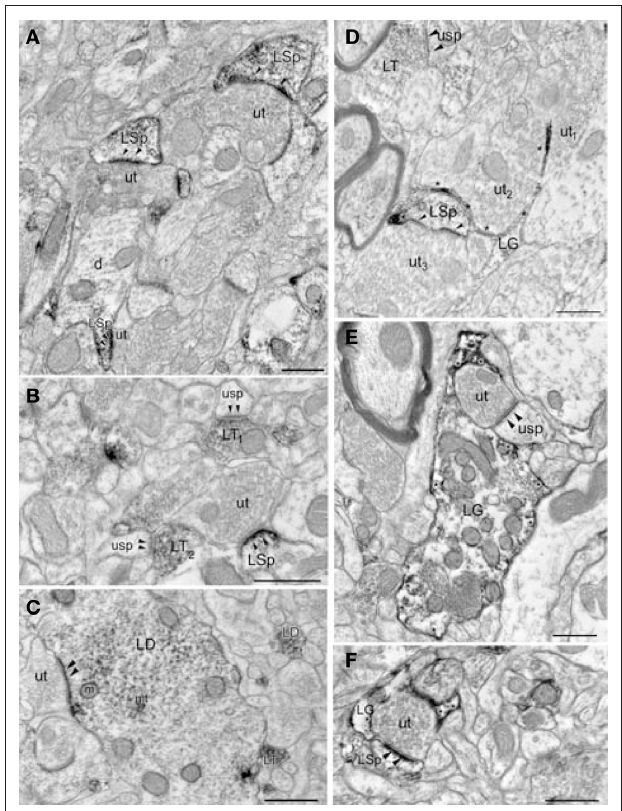
Figure 6 | Both LA neurons and glia are immunoreactive (ir) for β Ar. (A) Unlabeled terminals (ut) form asymmetric synapses onto β AR 248-ir spines (LSp). The spinous portion (LSp) of a dendrite (d) is β AR 248-ir. (B) An unlabeled terminal (ut) synapses (arrowheads) onto a β AR 248-ir spine (LSp). ) synapse (arrowheads) onto unlabeled spines β AR 248-labeled terminals (LT 1–2 (usp). (C) The β AR 248 reaction product in a dendrite (LD) is concentrated at the synapse (arrowheads) formed by an unlabeled terminal (ut) but also rims the microtubules (mt) and mitochondria (m). Also shown are a β AR 248-ir terminal (LT) and a small labeled dendrite (LD). (D) β AR 404-ir glial processes (LG, asterisks) are interposed between two unlabeled terminals (ut ). Also 1–2 shown are an unlabeled terminal (ut ) synapsing (arrowheads) onto a β AR 404 3 ir spine (LSp) and a β AR 404-ir terminal (LT) synapsing (arrowheads) onto an unlabeled spine (usp). (e) A β AR 404-ir glial process (LG) surrounds a terminal (ut) that synapses (arrowheads) onto a spine (usp). Asterisks denote β AR 404-ir along the plasma membrane. (F) A β AR 404 ir glial process (LG, asterisks) surrounds an unlabeled terminal (ut) that forms an asymmetric synapse (arrowheads) onto a β AR 404-ir spine (LSp). Scale bars = 0.500